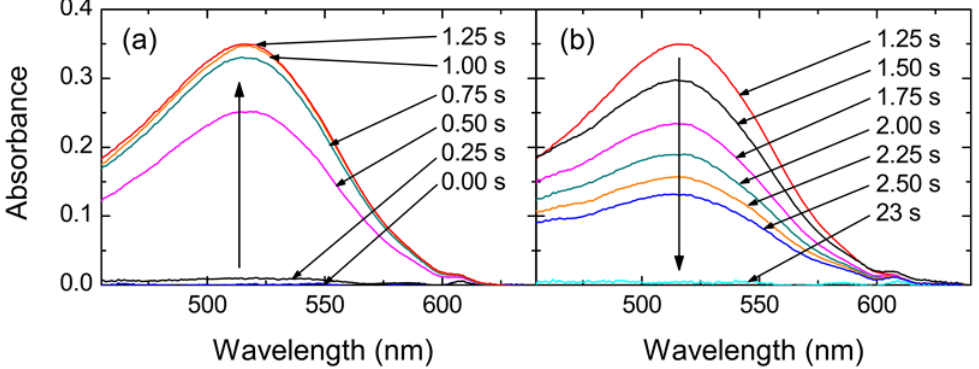
Figure 13. Absorbance spectra of spiroOH on a nanofiber, with white light and additional UV-light exposure. All molecules are initially in the transparent state; ( a ) UV illumination increases the absorbance up to a stable point in the photostationary state; ( b ) The absorbance decreases after the UV exposure has stopped. Reprinted with permission from [93]. Copyright 2012 Optical Society of